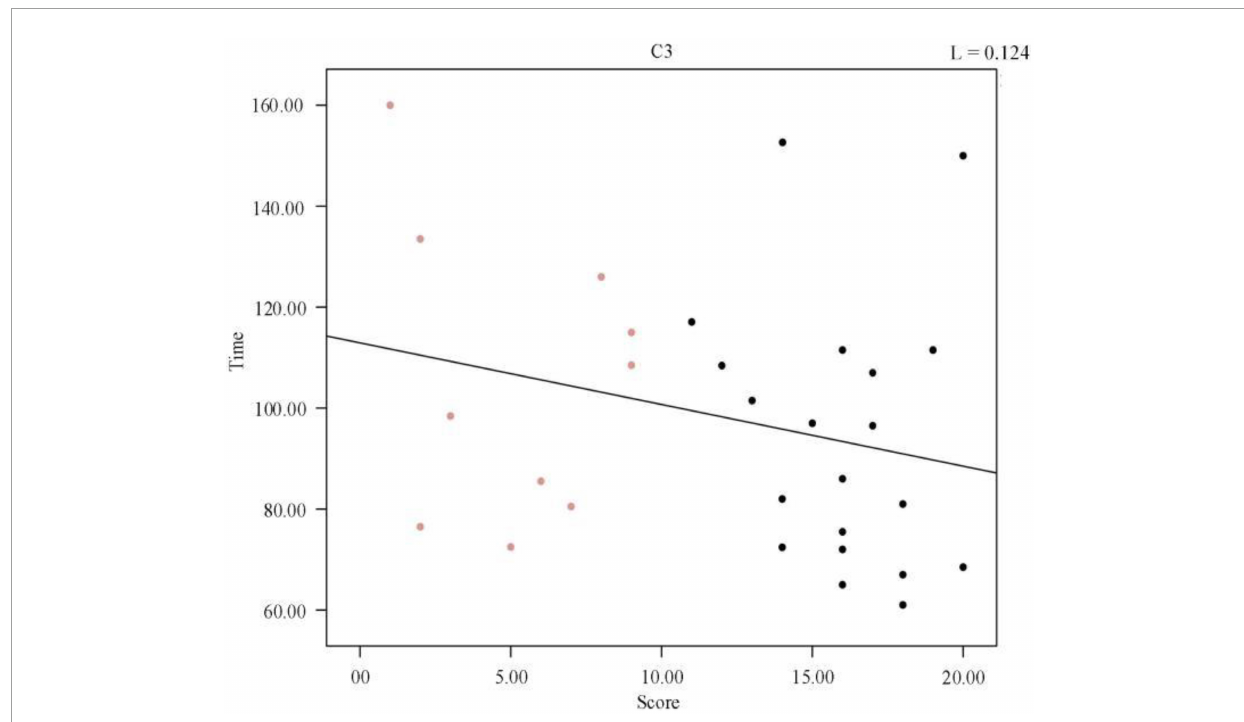
FIGURE4 Regression line between the duration of the first cycle of individual sleep and sleep quality score.